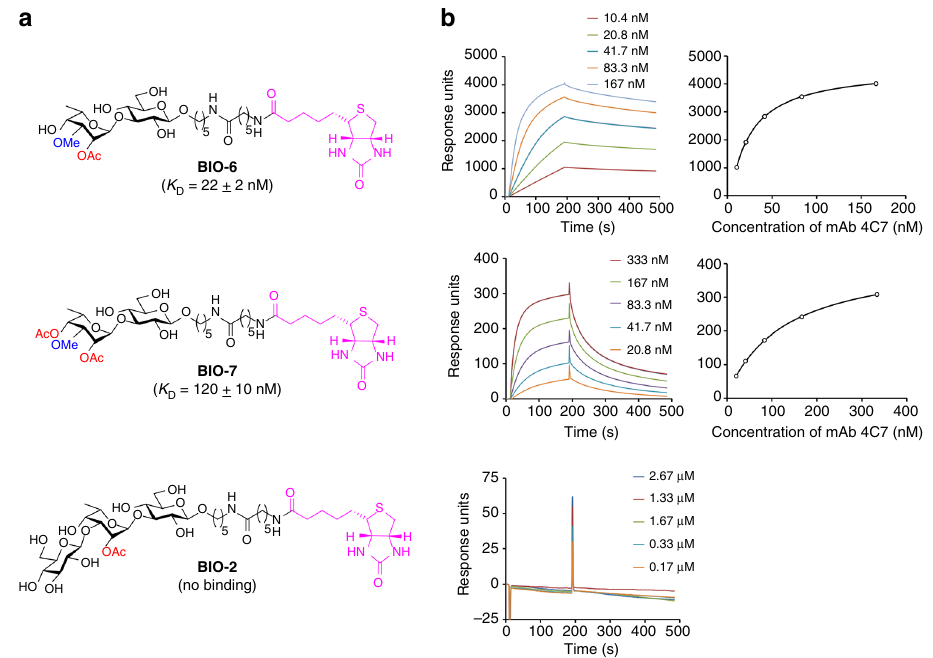
Fig. 6 K D values of mAb 4C7 binding to biotinylated oligosaccharides inferred by SPR. a Chemical structures of the biotinylated oligosaccharides with their corresponding K D values. The compounds were immobilized on the surface of a streptavidin-coated sensor chip. Samples (two-fold serial dilution of mAb 4C7) were injected over the sensor surface for 180 s (association), after which the mAb was allowed to passively dissociate for 300 s. K D values were calculated with a steady-state af fi nity model (response units vs concentration plots). Indicated K D values are the mean ± sd of three runs. b Representative sensorgrams and steady-state af fi nity model fi tting for each corresponding biotinylated oligosaccharides. See Supplementary Methods and Supplementary Figs. 11 and 168 – 170 for